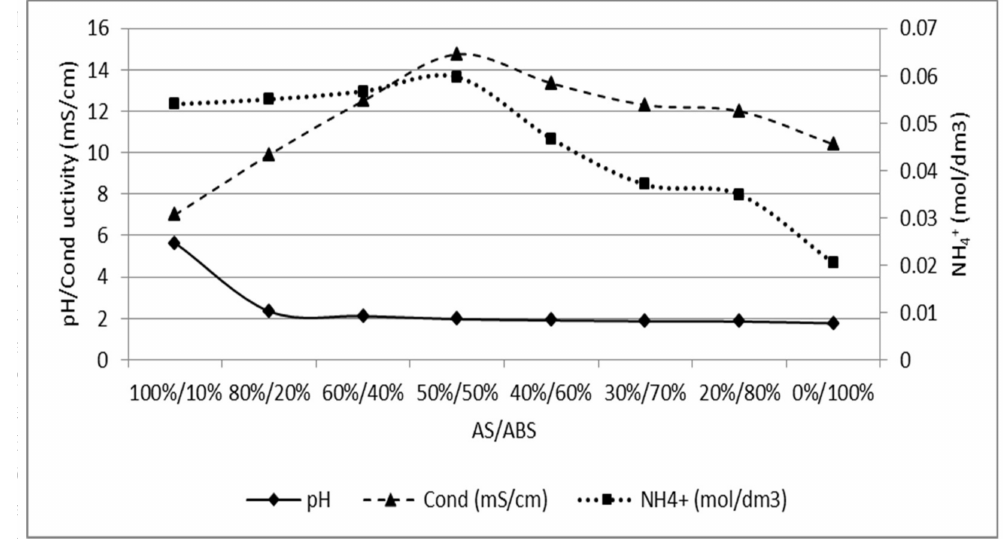
Figure A1. Calibration curve for different concentrations up to a solution of 0.03 M of AS and ABS, respectively. pH, conductivity and ammonium concentration is plotted against the ratio of